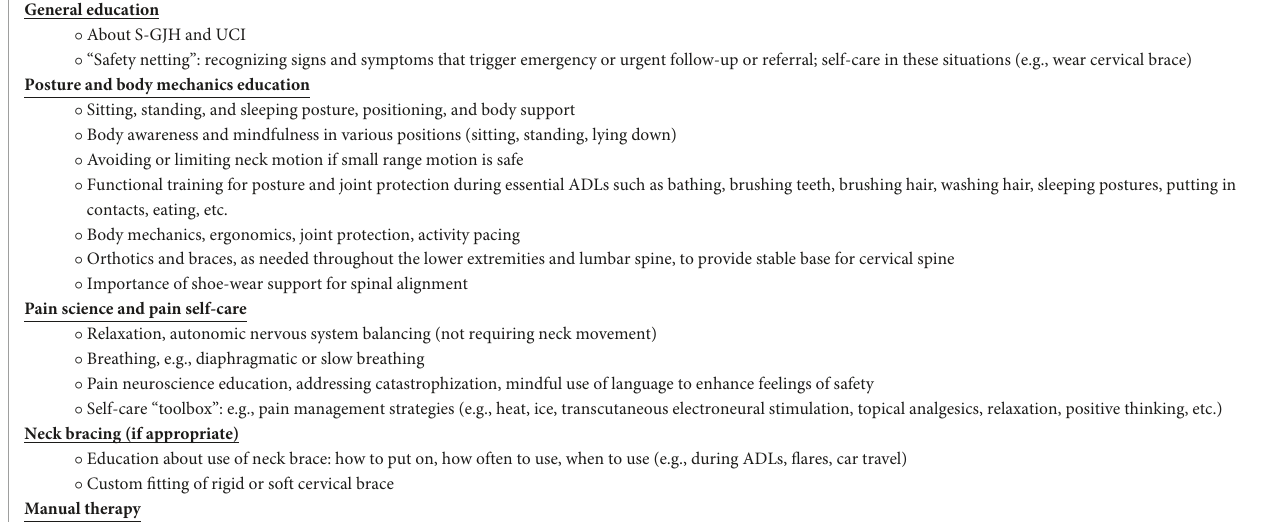
General education ◦ About S-GJH and